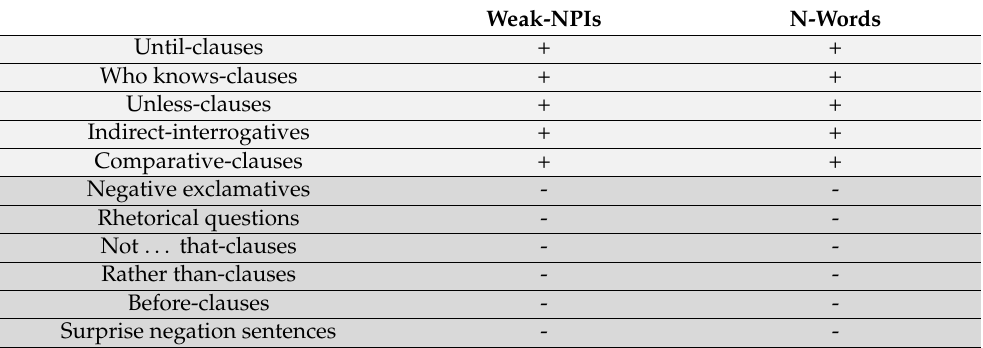
Table 1. Syntactic constructions with types of EN